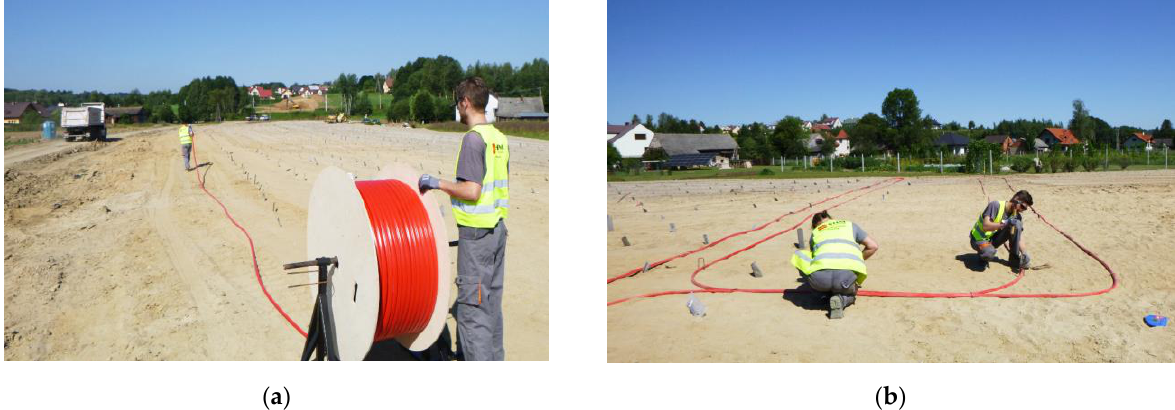
Figure 16. ( a ) Hydraulic sensor delivered to construction site in coil; ( b ) installation by stabilizing the sensor in the designed positions by means of the mounting brackets.